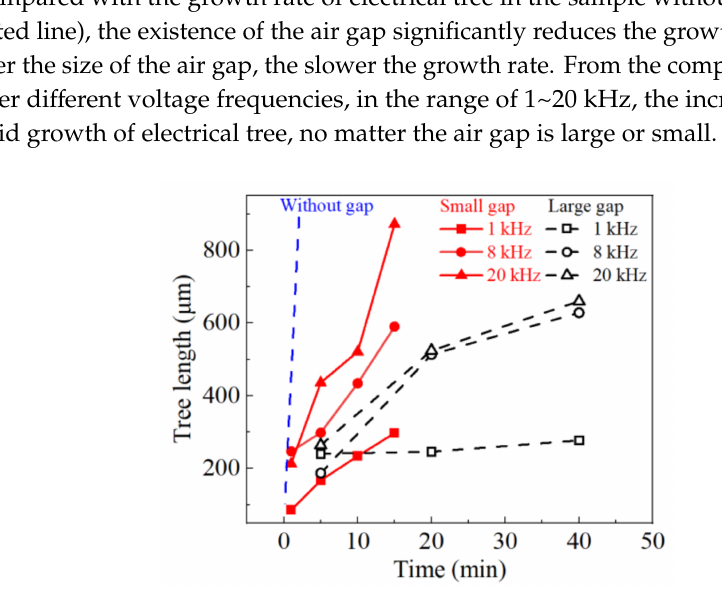
Figure 10. Electrical tree growing characteristics under bipolar square-wave voltage with air